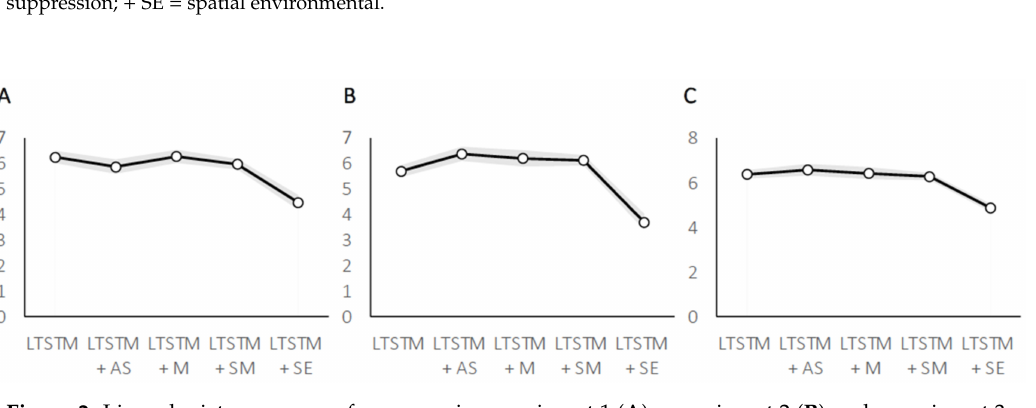
Figure 2. Lines depict average performances in experiment 1 ( A ), experiment 2 ( B ) and experiment 3 ( C ). Shadow lines depict standard error. Table 2. Descriptive statistics: means (standard deviations) and standard errors